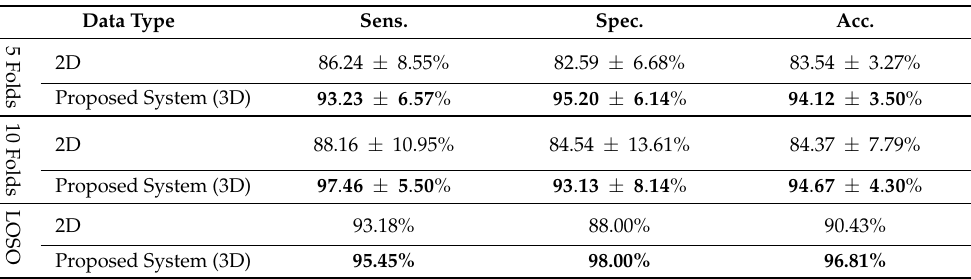
Table 5. Comparison on 2D and 3D data using the proposed